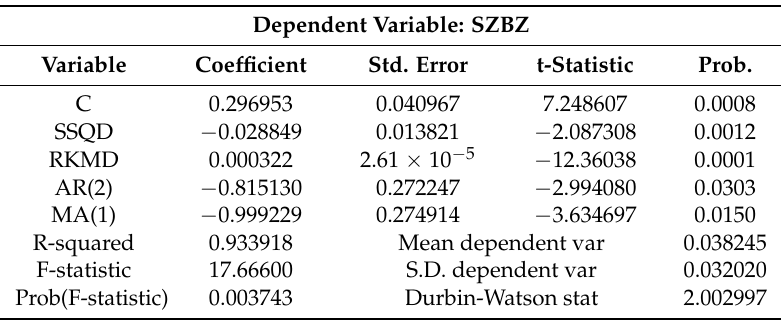
Table 11. Estimated results of the econometric model of the affected